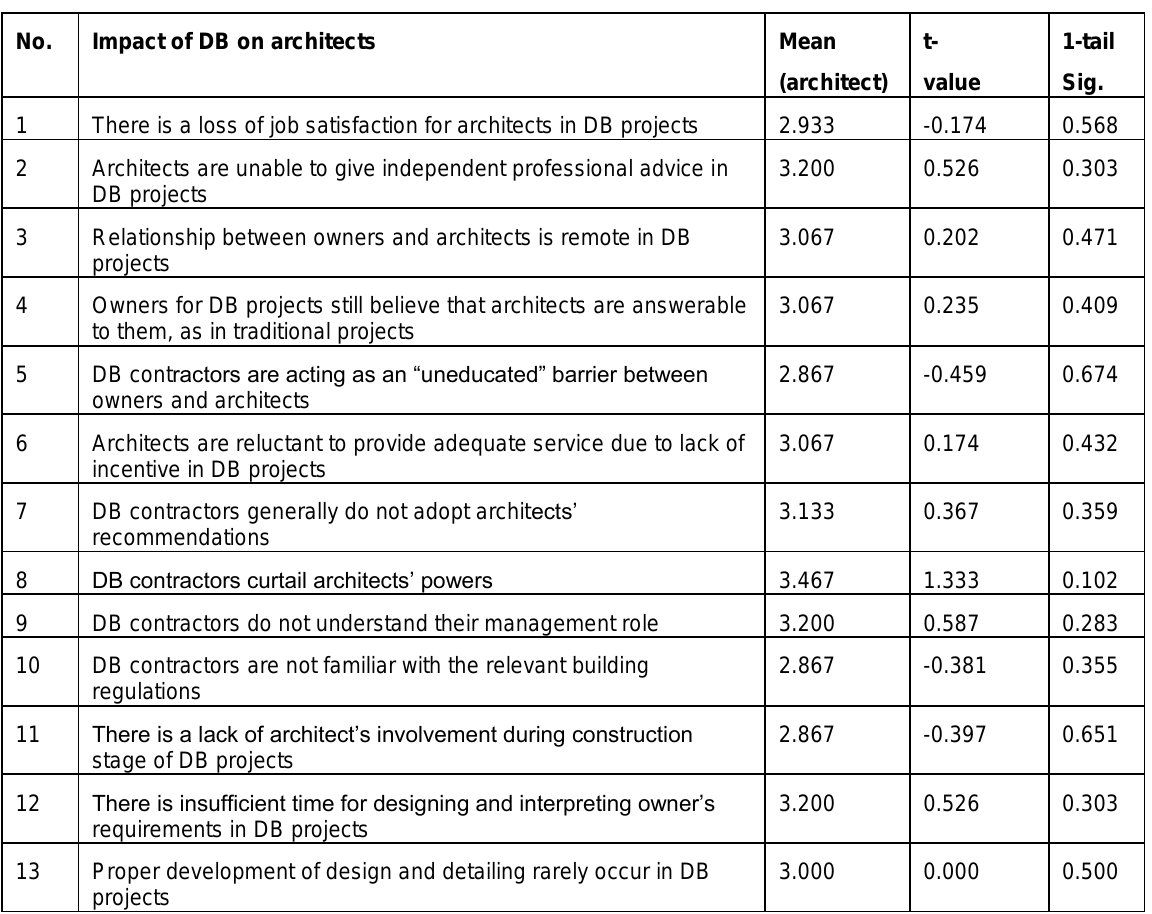
Table 2 : Survey results on impact of DB on